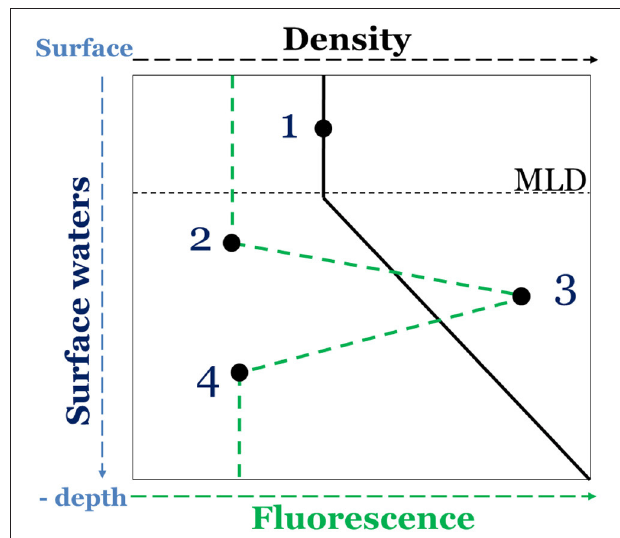
FIGURE 2 | Schematic representation of the sampling depth determination in the North Western Mediterranean Sea, based on density (black plot) and fluorescence (dashed green plot) depth